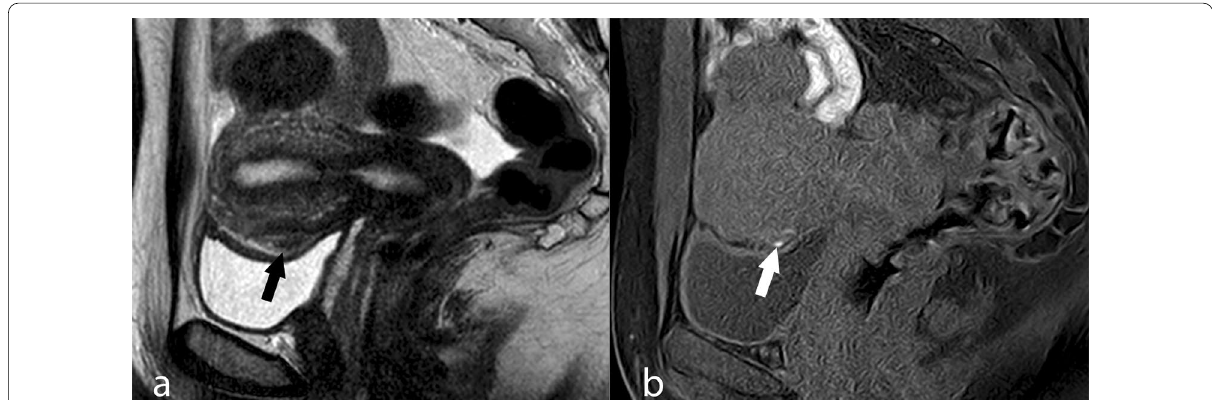
Fig. 14 Adhesive endometriosis of the vesico-uterine pouch. TSE T2w ( a ) and THRIVE ( b ) sagittal image. Small hyperintense spot-like images of the vesico-uterine pouch are seen. An endometriotic plaque was found through